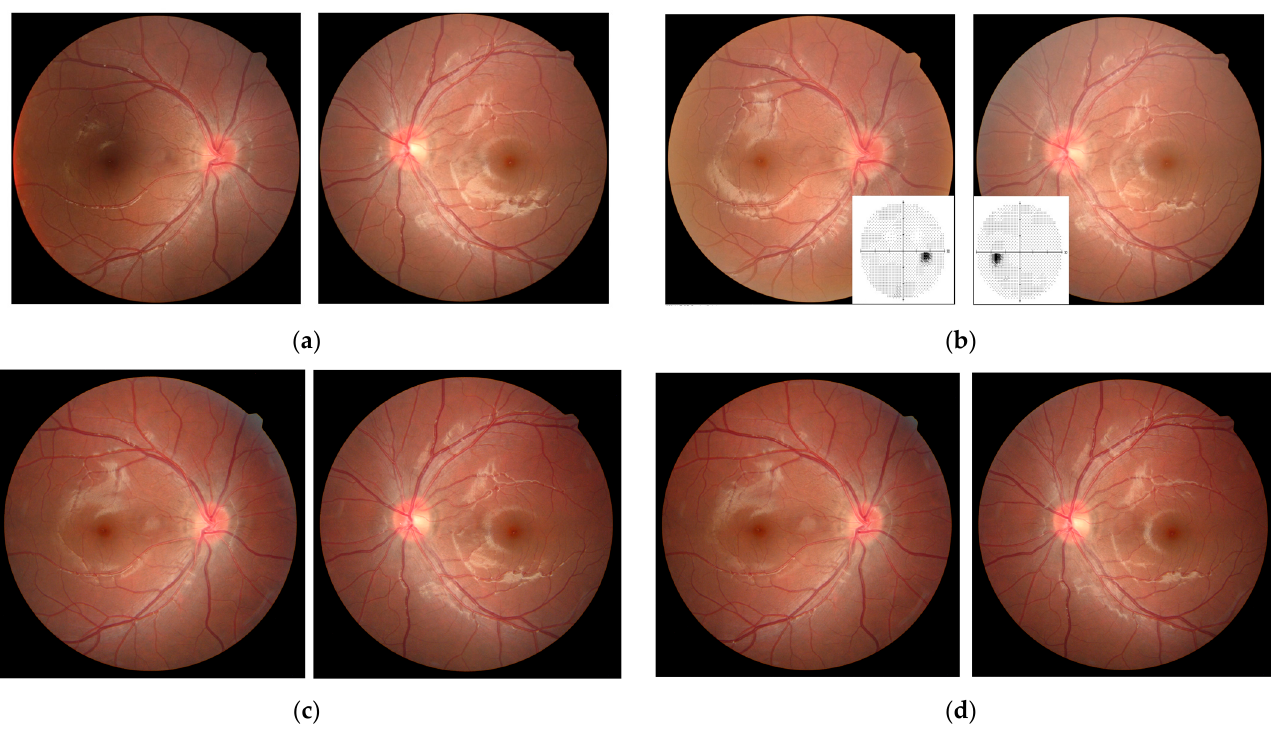
Figure 1. Color fundus photographs of both eyes showed serial changes of the optic disc edema on day 0 ( a ), day 8 ( b ), 3 months ( c ), and 10 months ( d ) post diagnosis of the disease. Automated central 30-2 Humphrey visual field-testing results revealed mild deficits in both eyes (( b ); insets). Unfortunately, the patient suffered multiple seizure attacks, left gaze deviation, and left lower limb numbness the following day. A cranial CT scan with contrast showed venous thrombosis in the superior sagittal sinus and frontal veins on the venography. CVST complicated with delayed onset increased intracranial pressure (IICP), papilledema, and focal seizure was diagnosed. The patient was then admitted to the pediatric intensive care unit. No remarkable findings were noted in the patient’s personal and family history. Laboratory examination of protein C, protein S, lupus anticoagulant testing by diluted Russell’s viper venom test, and peripheral blood smear revealed negative findings. The antithrombin activity level was 53.1% (the reference range in our hospital was 75–125%). After admission, an antiepileptic agent with levetiracetam (500 mg every eight hours intravenously), an antithrombotic agent with enoxaparin (total daily dose of 13,200 IU subcutaneously), and mannitol (70 g every six hours intravenously) were prescribed. Bilateral papilledema (Frisen grade 2 in the right eye and grade 1 in the left eye) was revealed on the follow-up dilated fundus examination 2 days